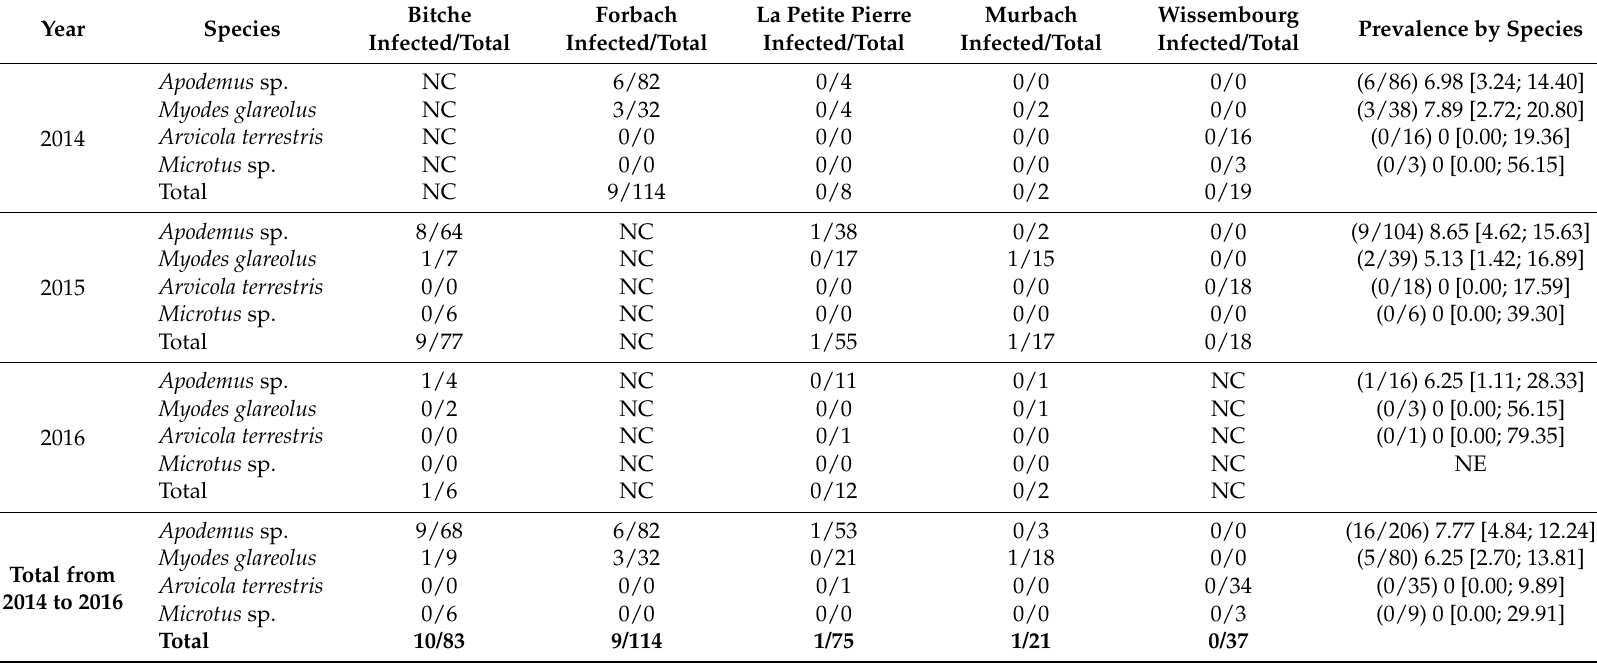
Bitche Forbach La Petite Pierre Murbach Wissembourg Prevalence by Species Infected/Total Infected/Total Infected/Total Infected/Total Infected/Total